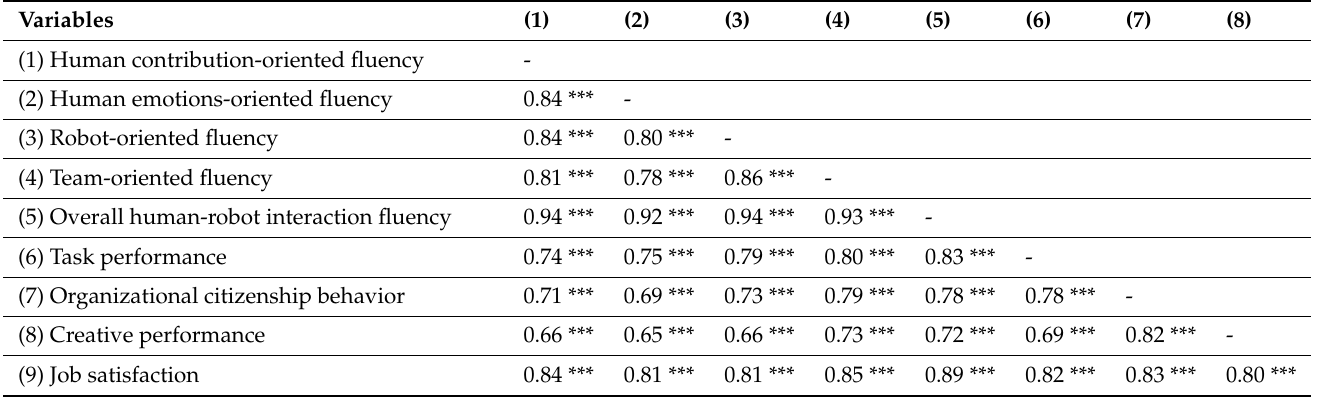
Table 2. Pearson correlation analysis among human–robot interaction fluency, task performance, organizational citizenship behavior, creative performance, and job satisfaction.